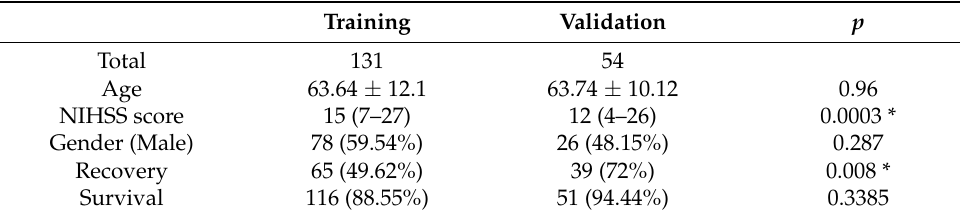
Table 2. Patient characteristics in the training and validation datasets.